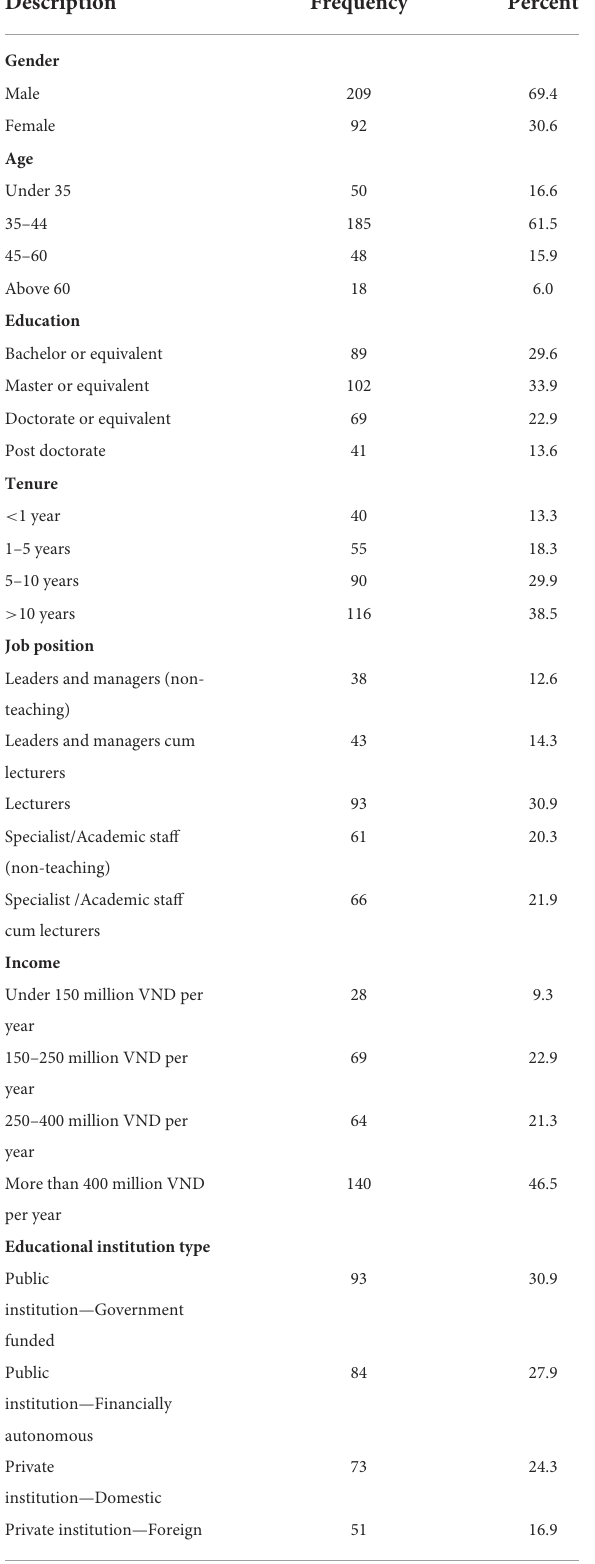
TABLE 1 Description of the respondents’